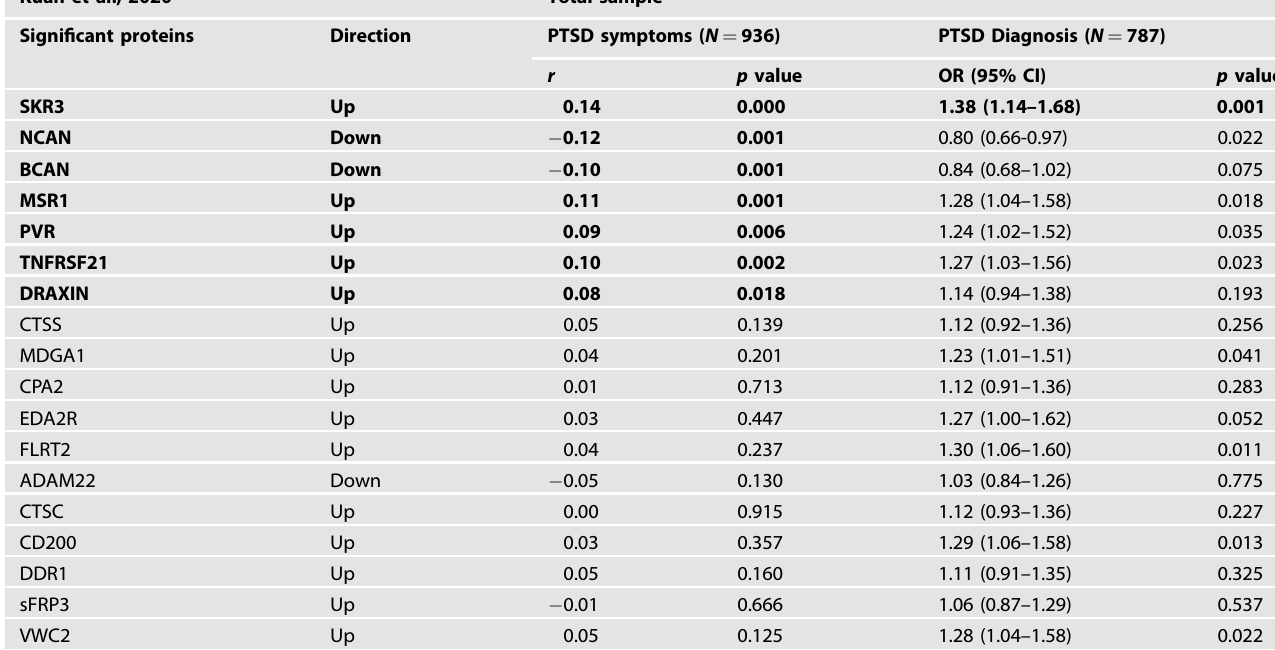
Table 1. Bivariate associations between proteins discovered in Kuan et al. (2020) and PTSD symptoms and diagnosis in the current